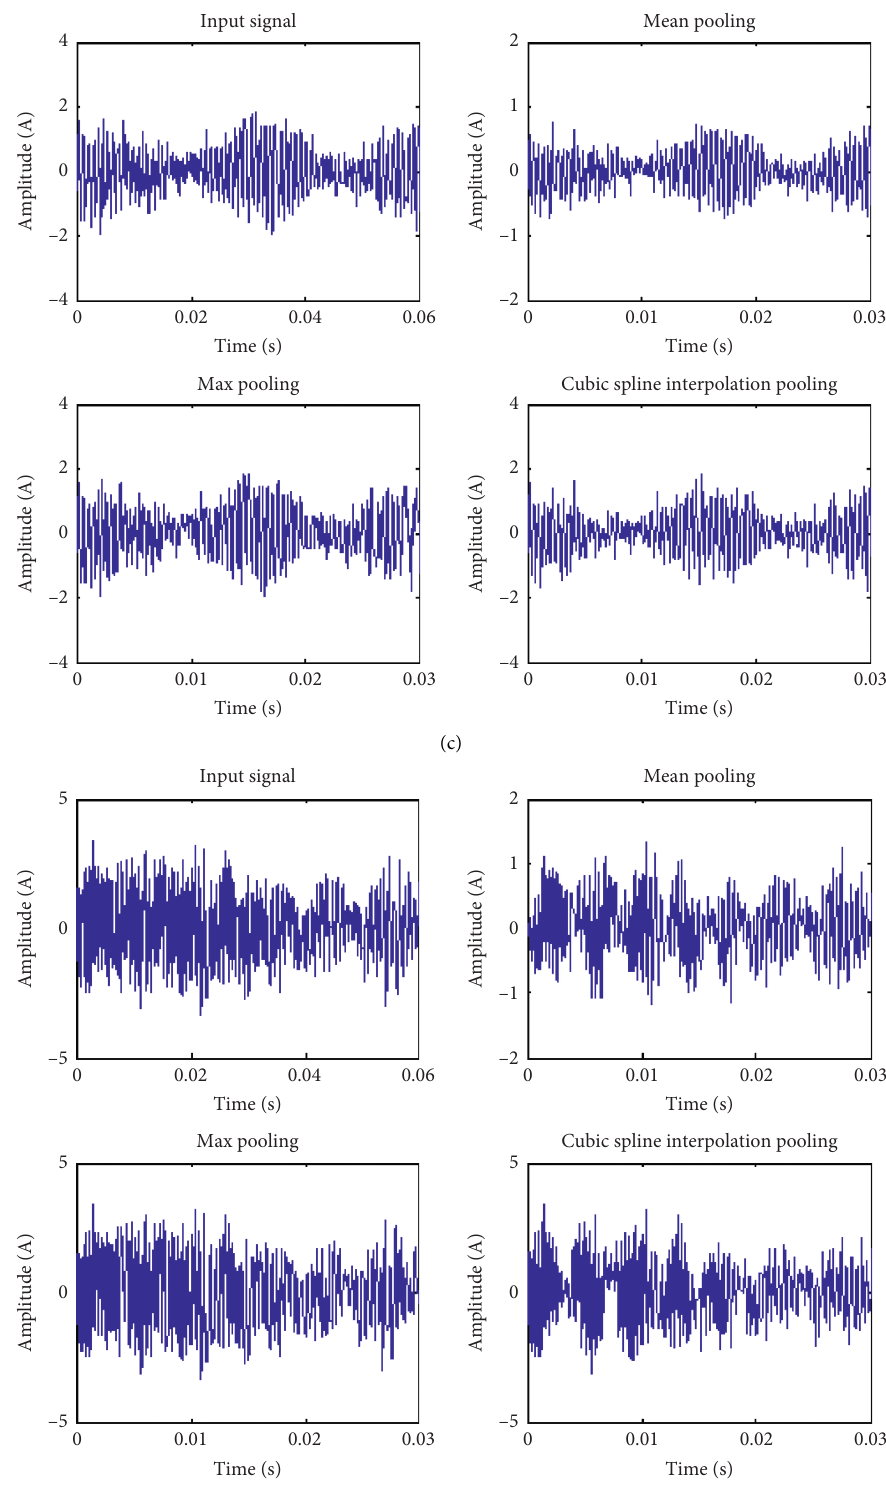
Figure 11: Pooling results of bearing status signals. (a) Normal state. (b) Rolling element damage. (c) Inner ring damage. (d) Outer ring